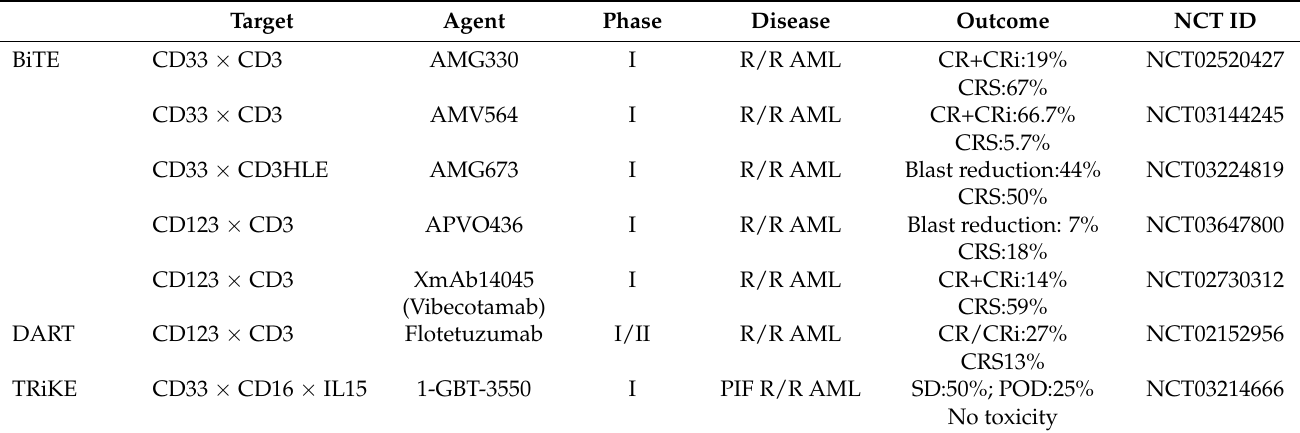
Table 1. Published results of clinical trials of bispecific antibodies in